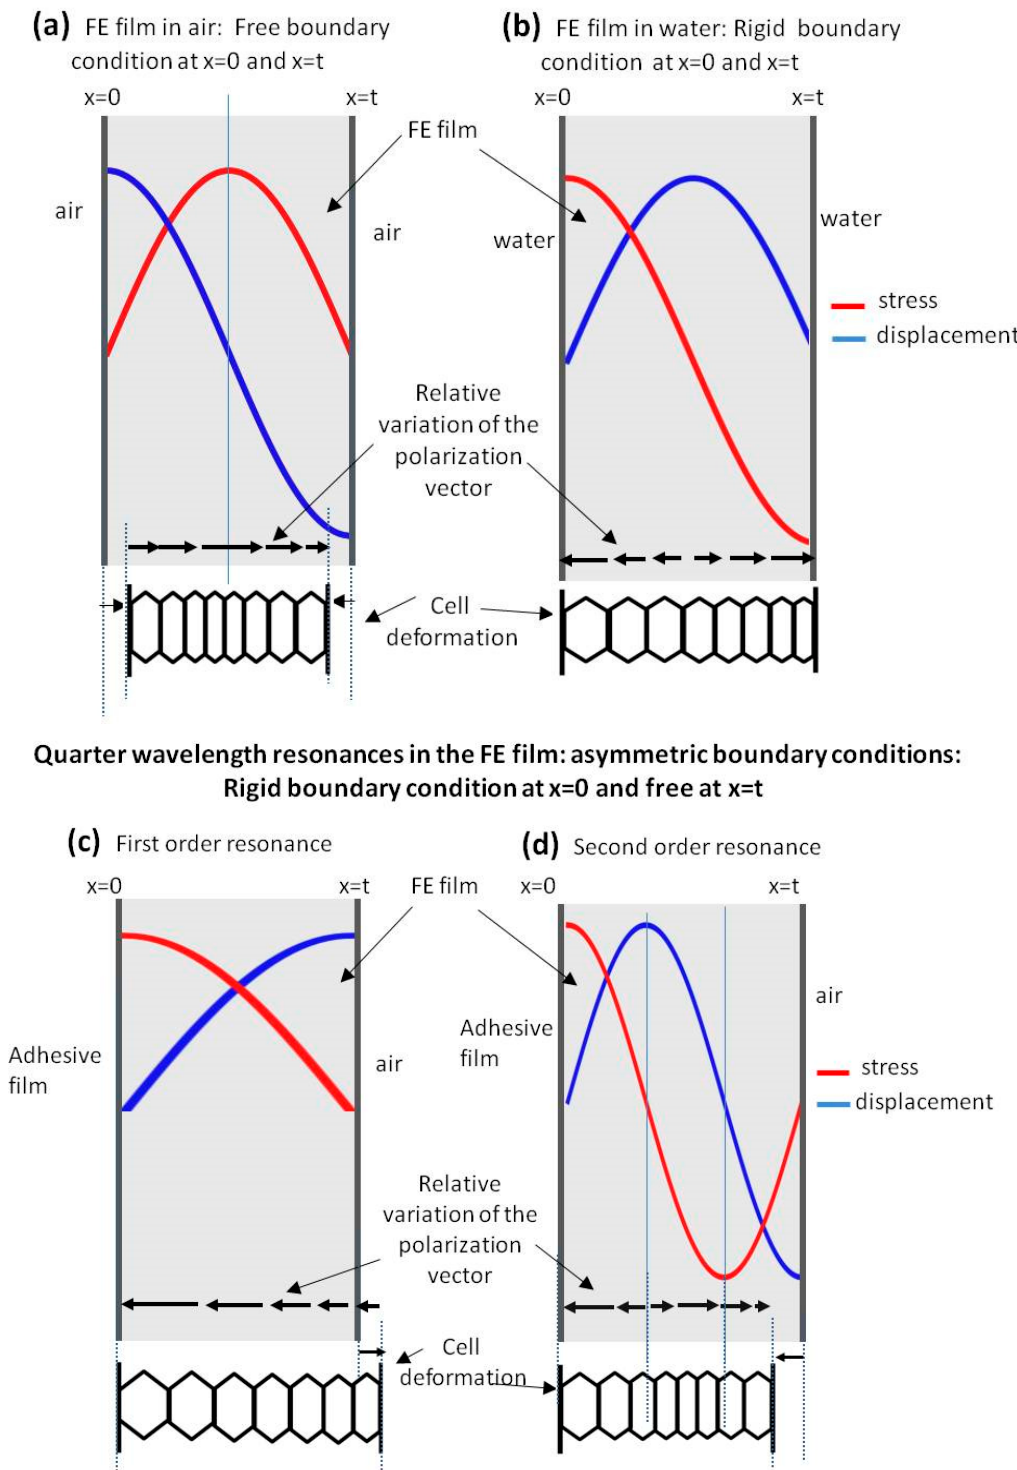
Figure 13. Representation of strain and stress, polarization variation and cell deformation distribution along the film thickness for different boundary conditions and resonance orders; ( a ) first half wave resonance with free boundary conditions; ( b ) first half wave resonance with rigid boundary conditions; ( c ) first quarter wavelength resonance; ( d ) second order quarter wave